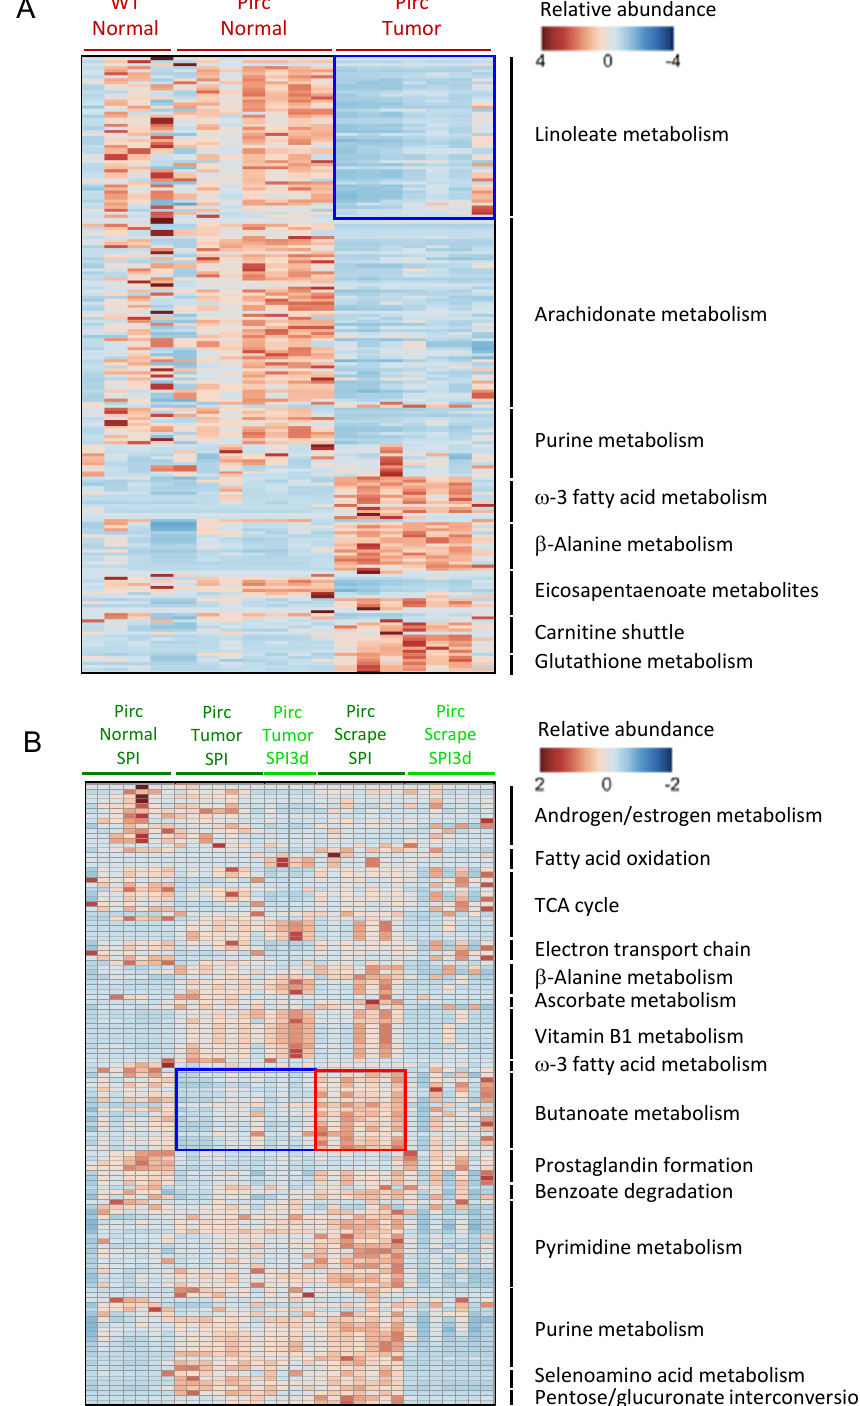
Figure 3. Heatmaps of enriched metabolomic pathways. ( A ) In the absence of SPI treatment, a Pirc tumor signature had reduced relative abundance of Linoleate metabolism, among other